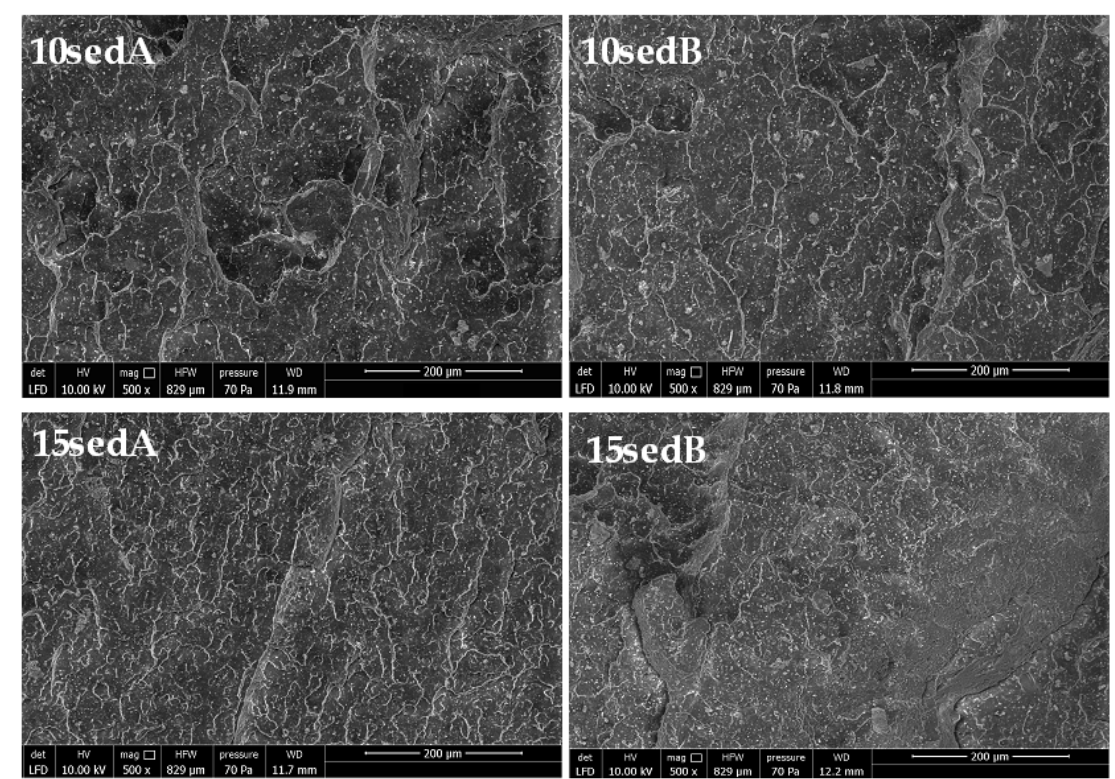
Figure 21. SEM images of PLA/CLS composite fractures.